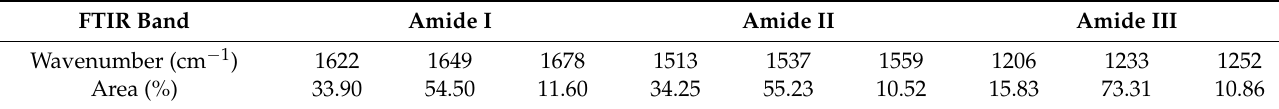
Table 1. Secondary structure determination for amide I, II and III in SPI films. FTIR Band Amide I Amide II Wavenumber (cm − 1